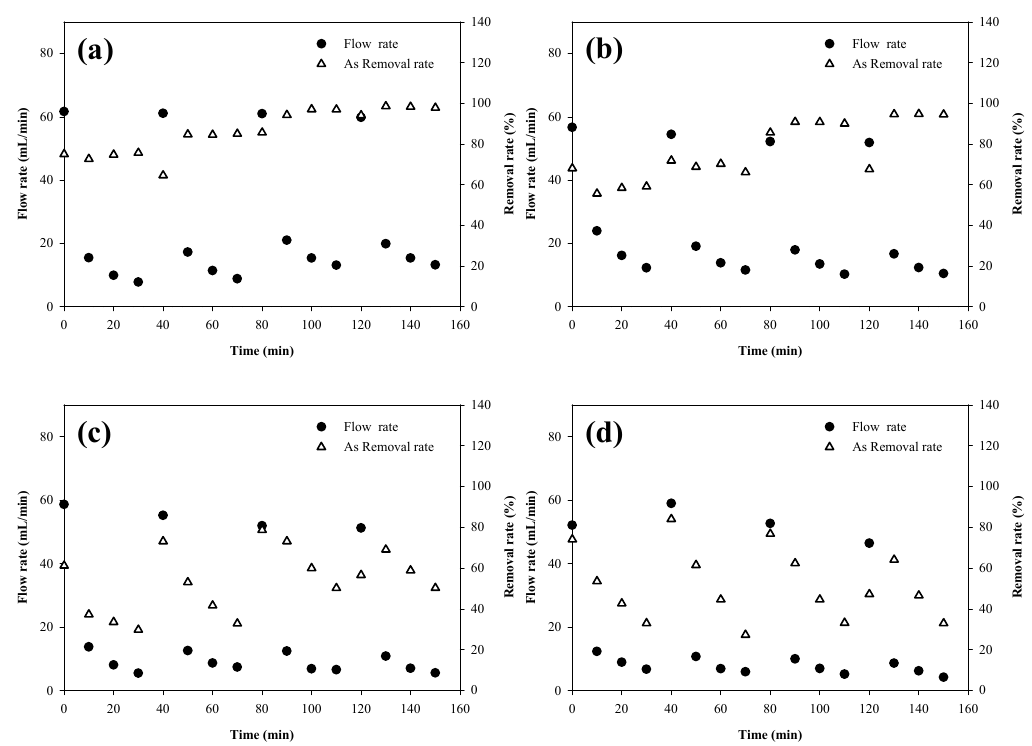
Figure 6. Effect of solution pH on the flow rate and As removal rate during the hybrid ion-exchange fabric/ceramic membrane processing of the As + Kaolin solution: (a) pH 4, (b) pH 6, (c) pH 8, and (d) pH 10.